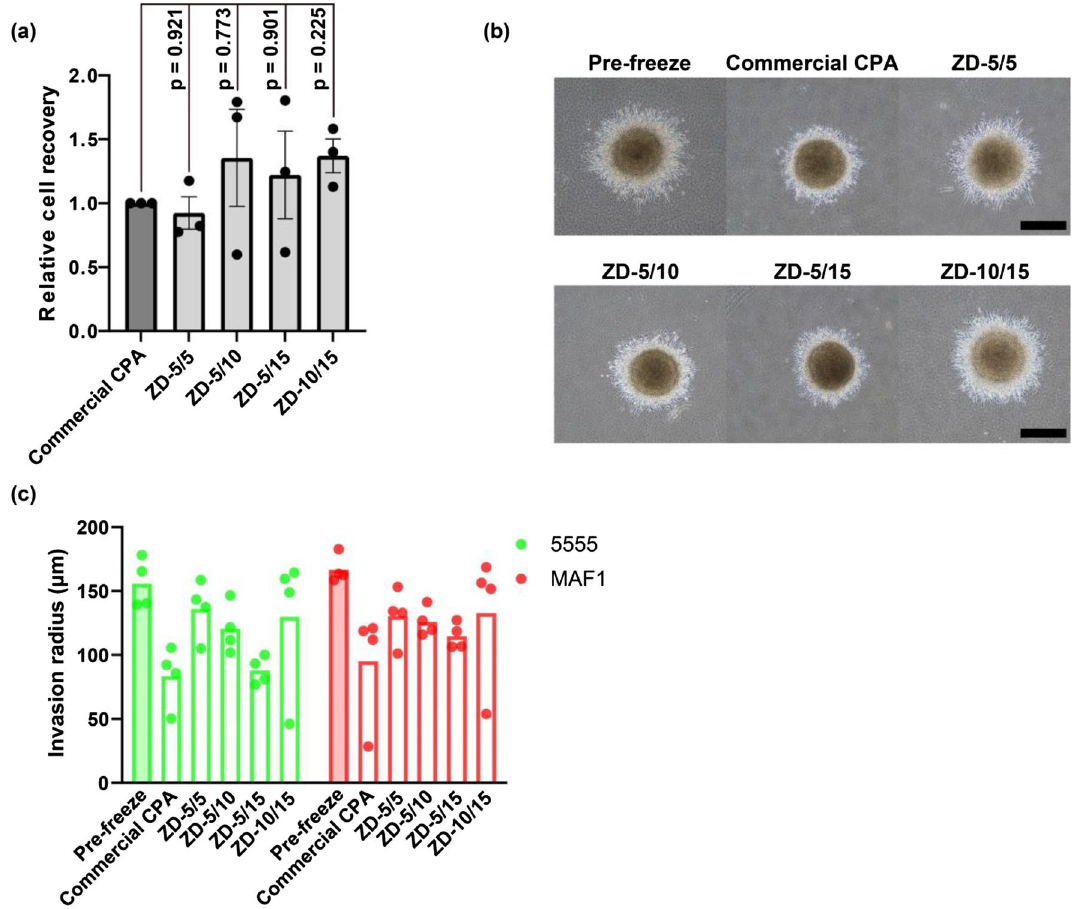
Figure 3. Relative cell recoveries and invasion ability of cryopreserved 5555/MAF1 co-cultured spheroids post-thaw using optimized mixtures of zwitterion and DMSO. ( a ) Relative cell recoveries of cryopreserved 5555/ MAF1 co-cultured spheroids measured immediately post-thaw ( n = 3, biological triplicates). ( b ) Typical images for invasion of spheroids after 24 h of incubation post-thaw. All images are in Fig. S11. Scale bar represents 500 µm. ( c ) Invasion radius of spheroids after 24 h of incubation post-thaw ( n = 1, experimental quadruplicates). The bar shows standard errors. The commercial CPA employed was CultureSure® freezing medium (Fujifilm Wako Pure Chemical